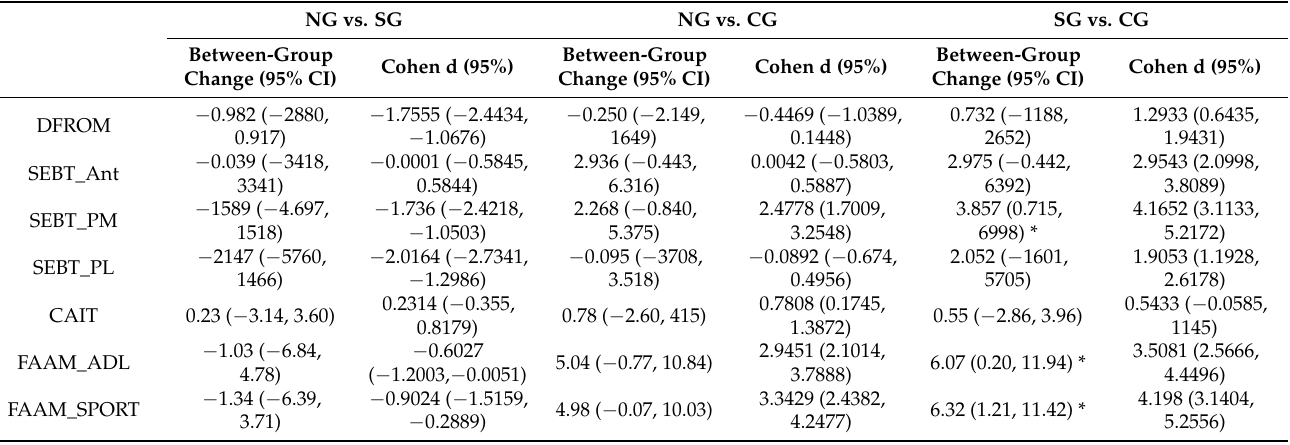
Table 3. Between-Groups Effect